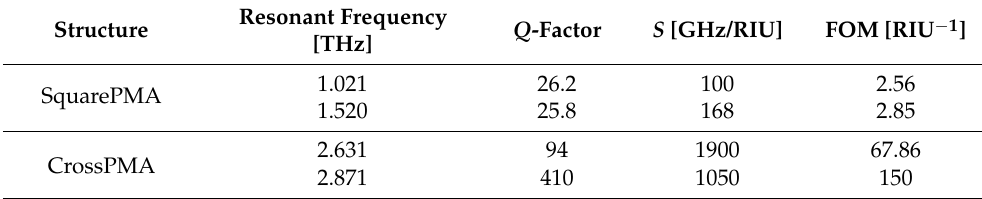
Table 2. Comparison of sensing performance.